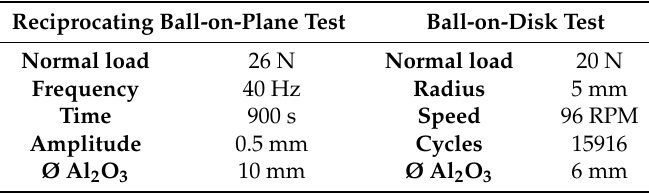
Table 3. Testing parameters of wear tests.